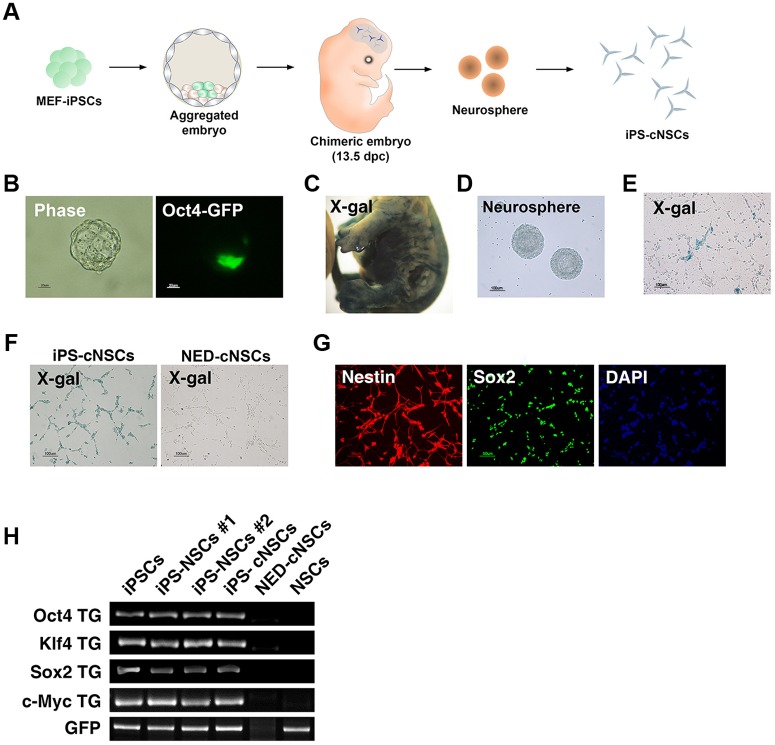
In vivo differentiation of iPSCs into NSCs after chimera formation.(A) Scheme of in vivo differentiation of iPSCs into NSCs. (B) Aggregated embryo with iPSCs. iPSCs could incorporate into the ICM (Oct4-GFP+). (C) X-gal staining of chimeric embryos (iPSCs). (D) Neurosphere formation and (E) 2D culturing of NSCs derived from a chimeric embryo. X-gal-positive staining of in vivo-differentiated NSCs derived from iPSCs. (F) X-gal staining of iPS-cNSCs and NED-cNSCs. iPS-cNSCs were positive for X-gal staining, but NED-cNSCs were not. (G) iPS-cNSCs expressed NSC markers, such as NESTIN and SOX2, as determined by immunocytochemistry. (H) Genotyping of transgenes in iPSCs, iPS-NSCs (#1 and #2), iPS-cNSCs, NED-cNSCs, and control NSCs (OG2+/-/ROSA26+/-). iPSCs and iPS-derived cells contained transgenes.